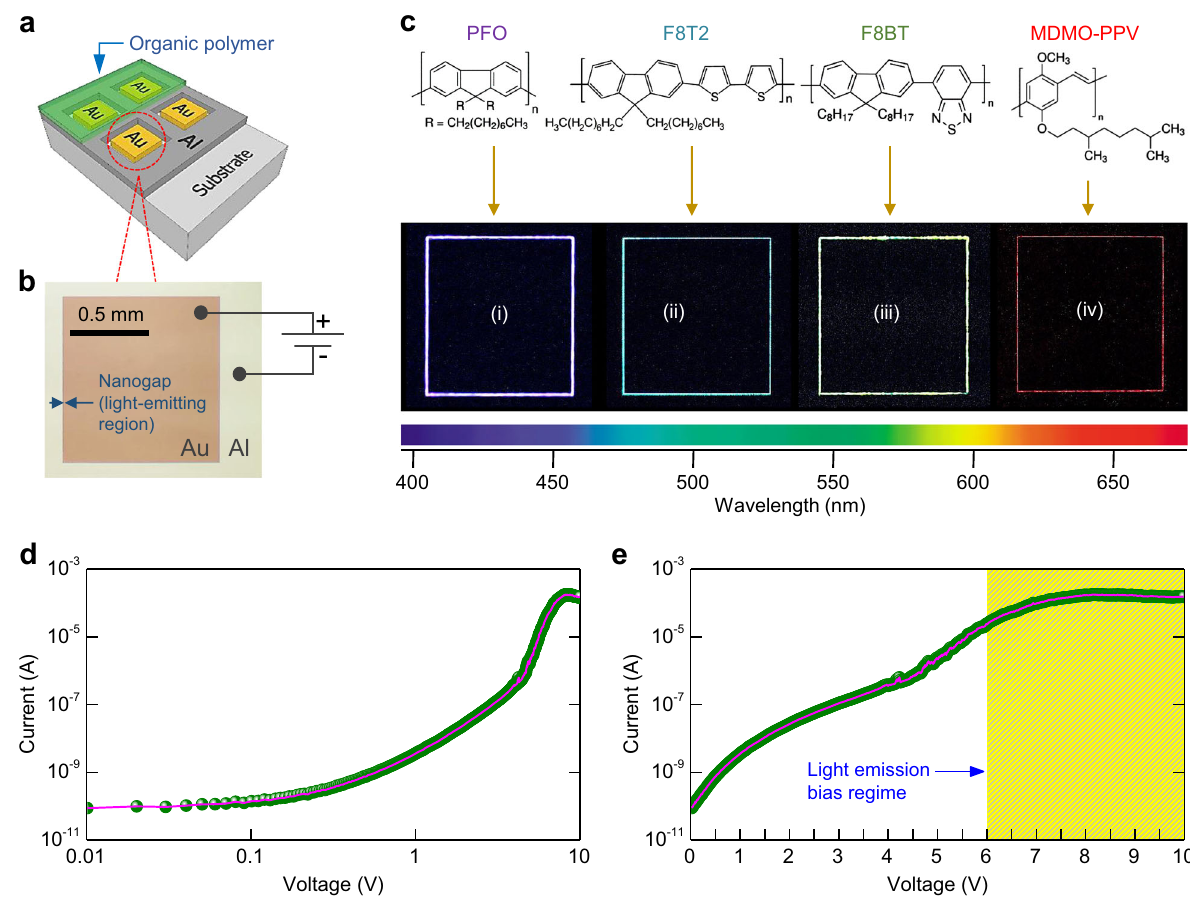
Fig. 4 Organic light-emitting nanogap diodes developed using a-Lith. a Schematic of coplanar nano-OLED devices. b Optical micrograph of square-shaped nano-OLED device consisting of asymmetric Al/Au electrodes. c Chemical structures of the various polymers employed and photographs of the corresponding nano-OLEDs in operation: (i) poly(9,9-di- n -octyl fl uorenyl-2,7-diyl) (PFO), (ii) poly(9,9-dioctyl fl uorene- alt - bithiophene) (F8T2), (iii) poly(9,9-dioctyl fl uorene- alt -benzothiadiazole) (F8BT), and (iv) poly[2-methoxy-5-(3 ′ ,7 ′ -dimethyloctyloxy)-1,4-pheny- lenevinylene] (MDMOH-PPV). d Log – log plot of the current – voltage characteristics of a F8T2-based nano-OLED. e Semi-logarithmic plot of the I – V characteristics highlighting the bias region where detectable light emission